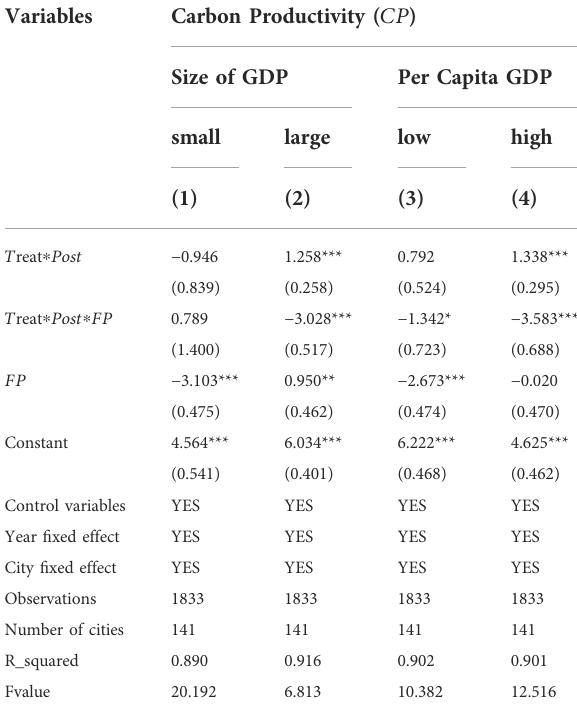
TABLE 8 Estimations under different economic development